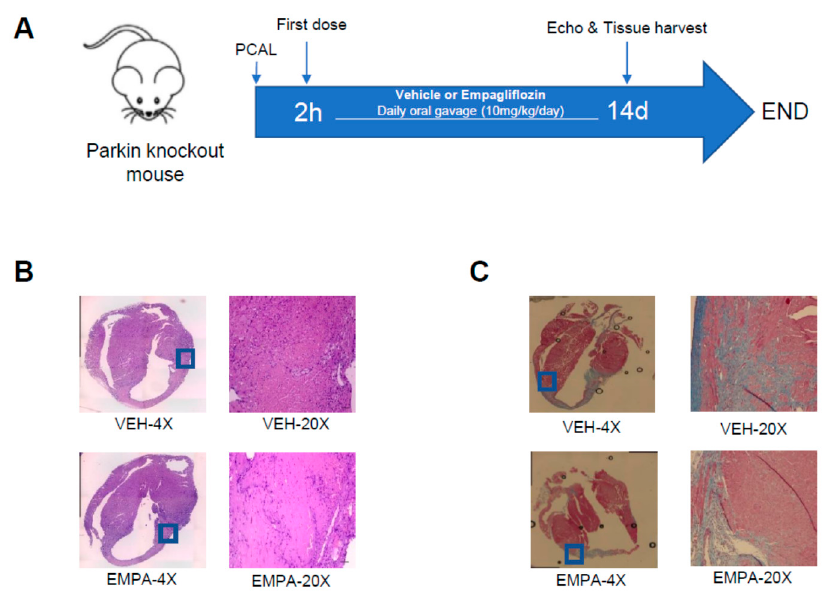
Table 2. Assessment of cardiac function and post–infarction cardiac remodeling by echocardiog-